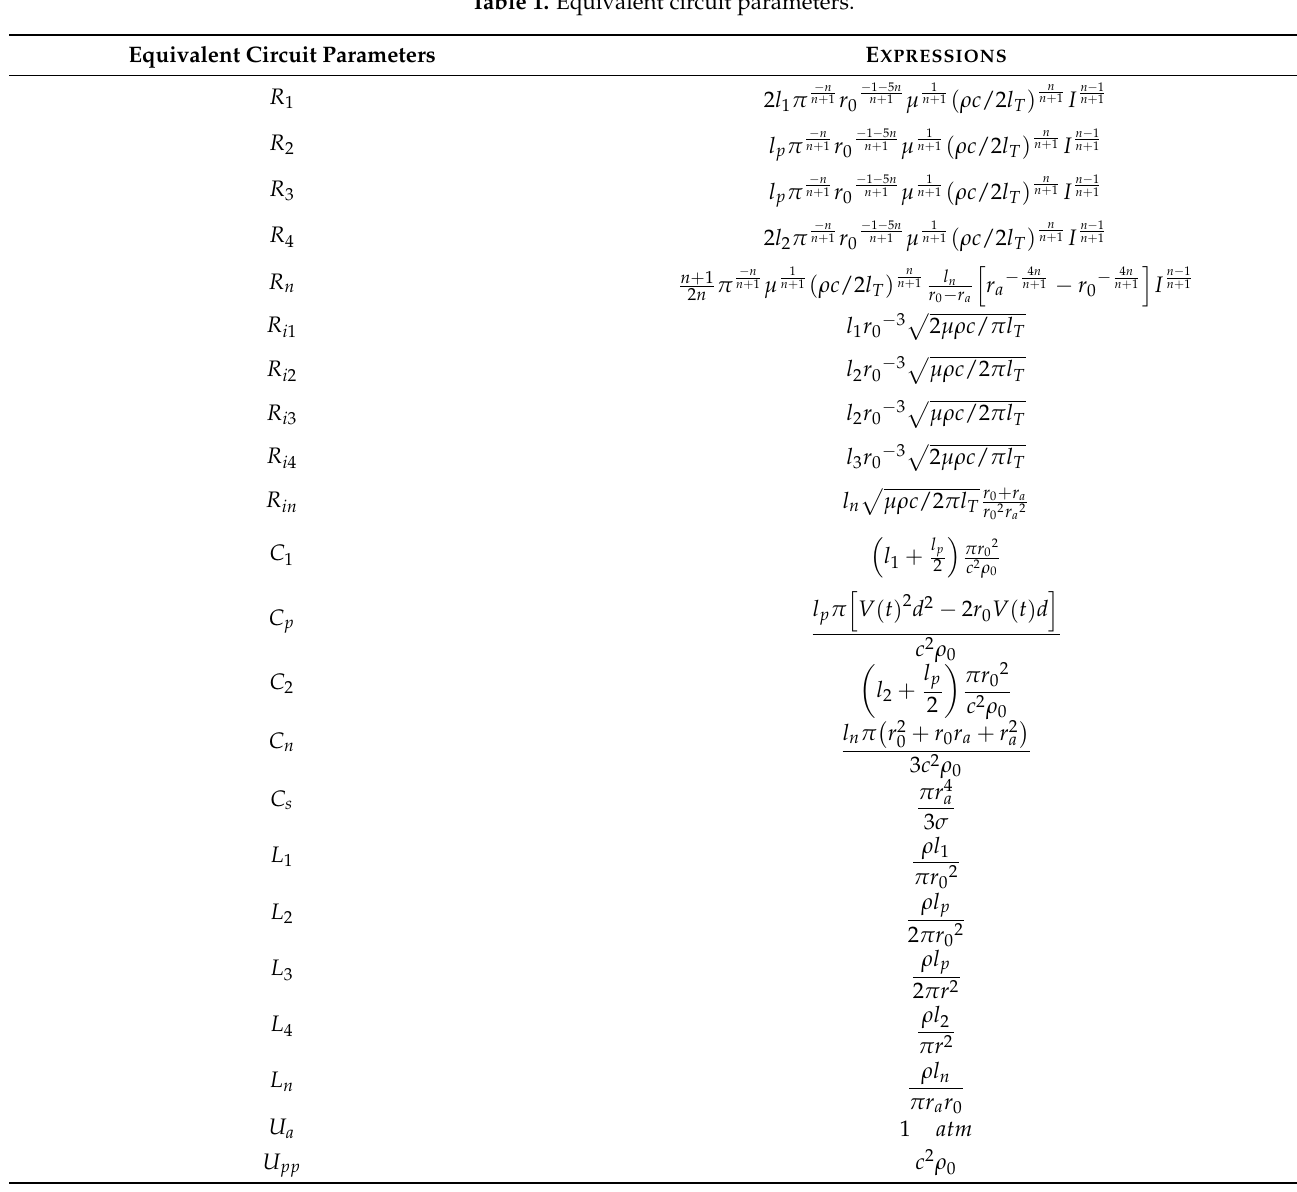
Figure 4. Equivalent circuit diagram. The corresponding equivalent circuit parameters are listed in Table 1. Table 1. Equivalent circuit